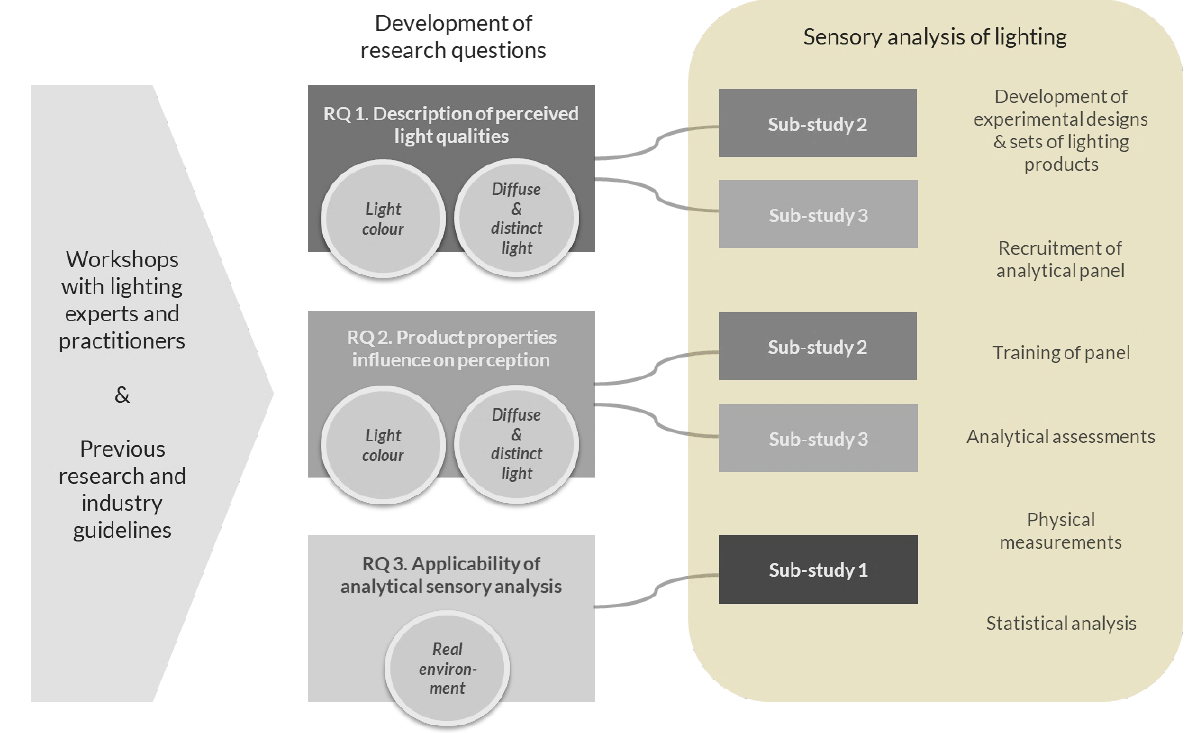
Figure 1. Flowchart of the research